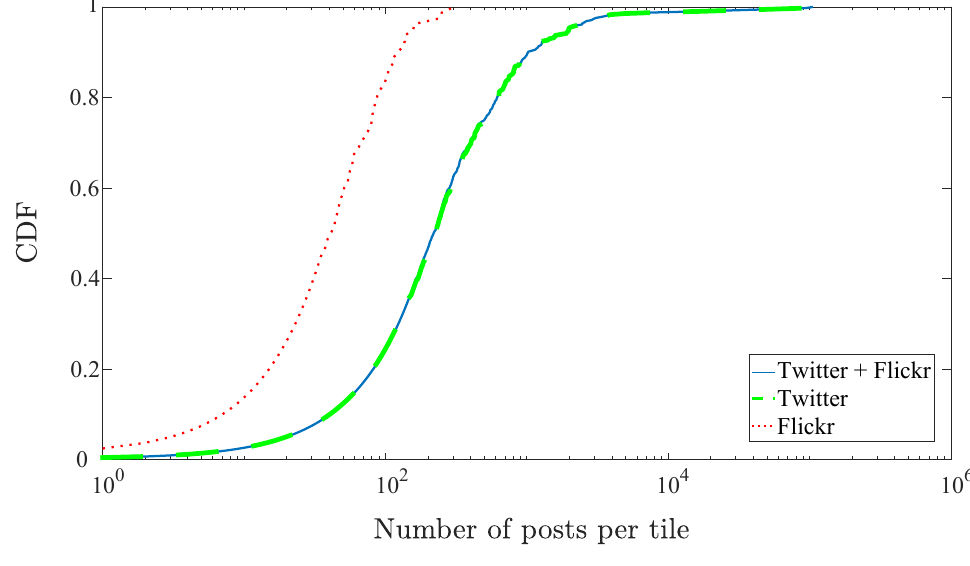
Figure 3. CDF of geotagged posts in the scenario.